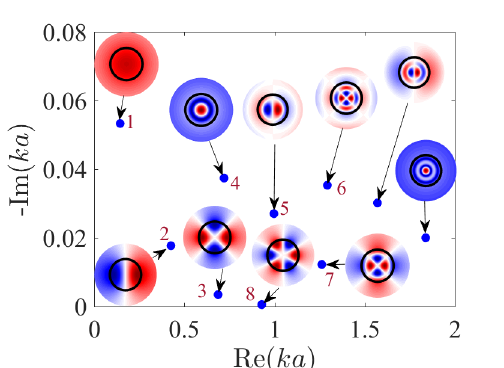
Figure 4: The Mie resonant complex eigenfrequencies (close circles) and corresponding resonant modes (the com- ponent E z ) of isolated cylinder.